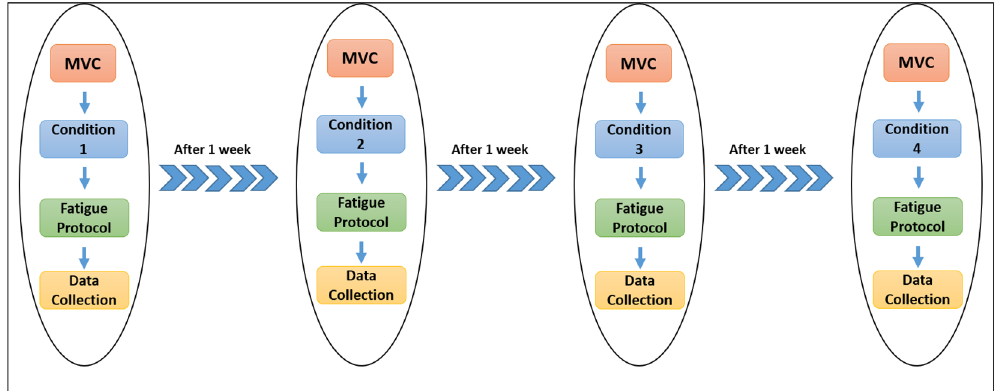
Figure 1. Flow diagram for the study. Conditions 1 to 4 are included no-tape, sham, facilitatory and inhibitory in a random order for each subject.